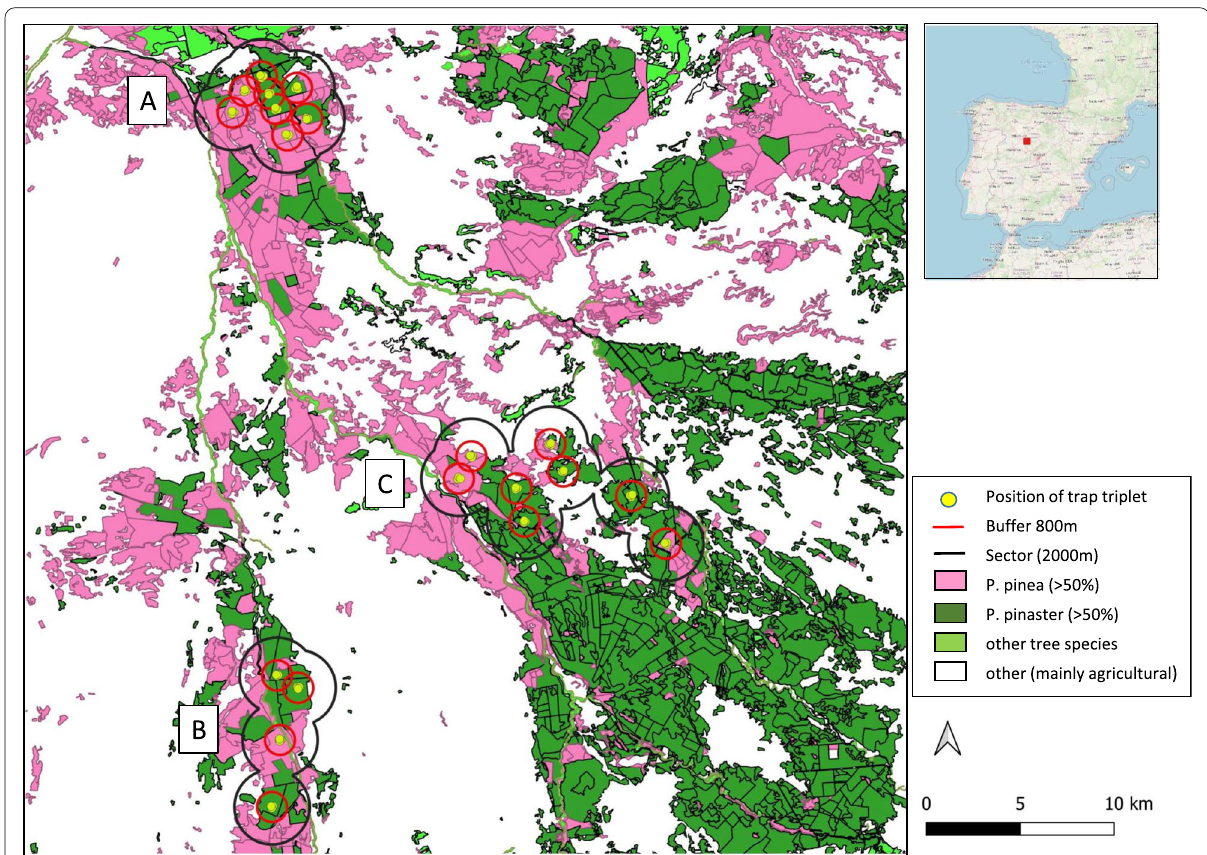
Fig. 1 Map of the study area with position of trap triplets, buffers of 800 m radius (red circles), the three sectors A, B, C (black line for the joint 2 km buffers), and the forest composition. The red square on the map of Spain (top‑right map) indicates the localization of the study area. The coordinates of the center of sector A are 41.5028801 and 4.54603389, in decimal degrees −